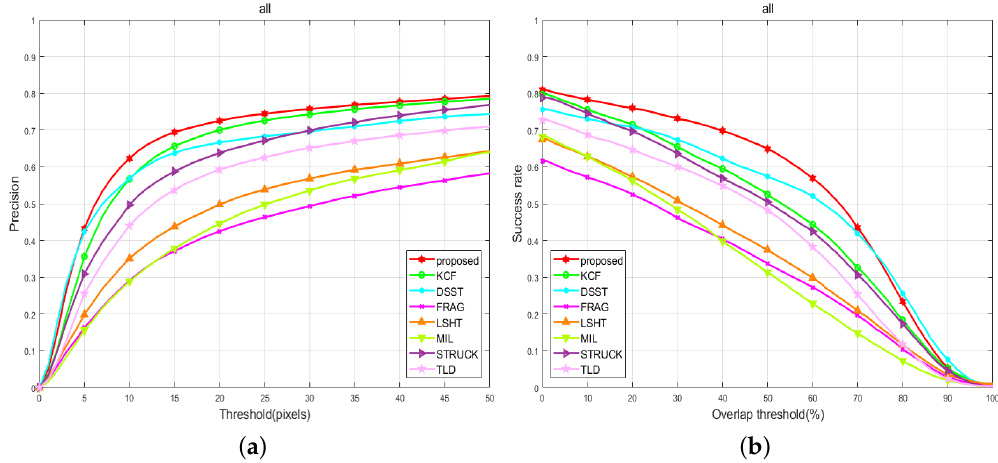
Figure 5. The precision plots and success plots over all 100 sequences. The legend of the plots indicates the state-of-the-art trackers. ( a ) precision plots; ( b ) success plots.